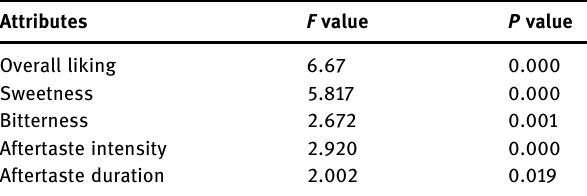
Table 6: Di ff erences in mean overall liking and sensory attributes of chocolate prepared using the static roasting and the